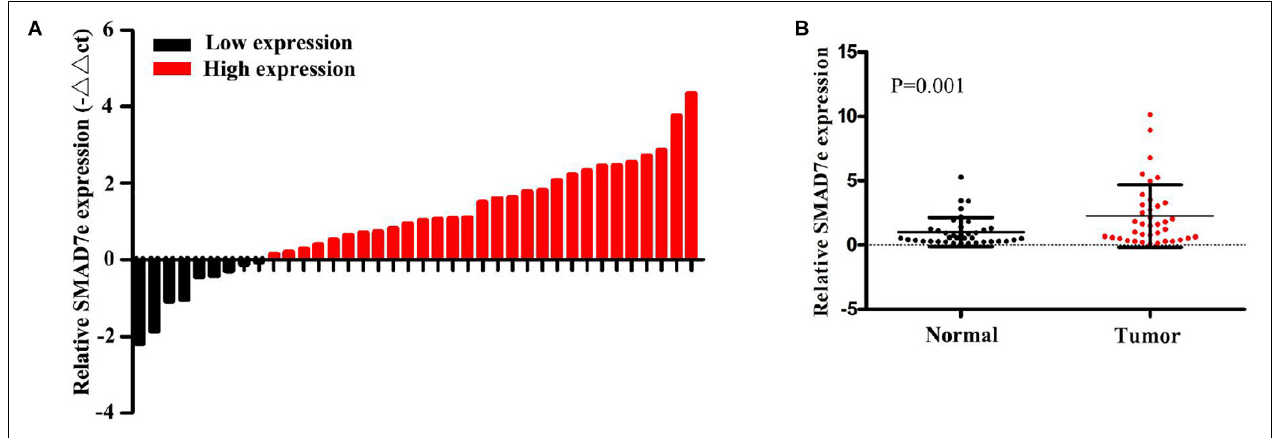
FIGURE 1 | The expression of SMAD7e in bladder cancer. (A) SMAD7e was up-regulated in bladder cancer. The relative expression levels of SMAD7e were detected by qPCR in 38 bladder cancer patients. (B) The relative expression level of SMAD7e was significantly increased in bladder cancer tissues compared to paired normal tissues. Data are shown as the mean ± SD.